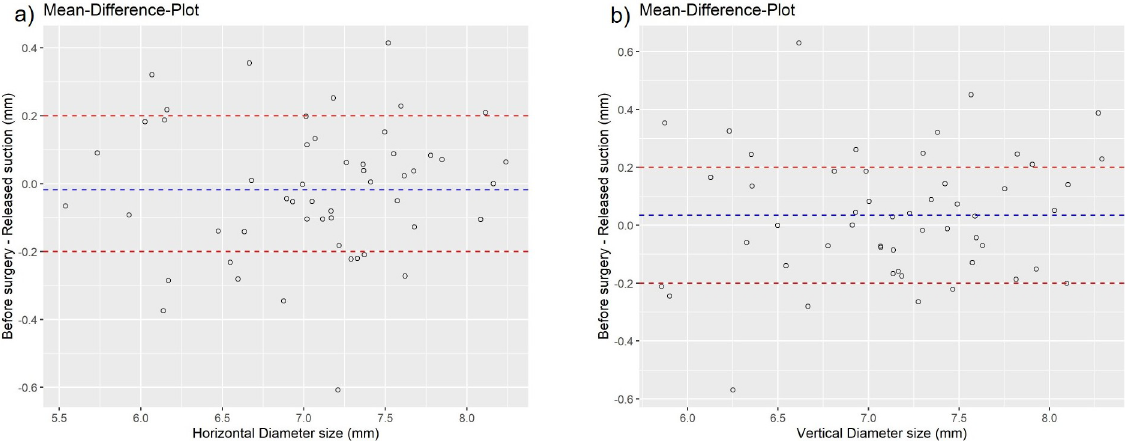
Fig 3. Differences in the measures of the horizontal diameter (a) and vertical diameter (b) of the pupil before surgery and at the time point “released suction,” each measured on the same subject. The mean differences and the 95% confidence intervals of the differences are within the equivalence range [ − 0.2,